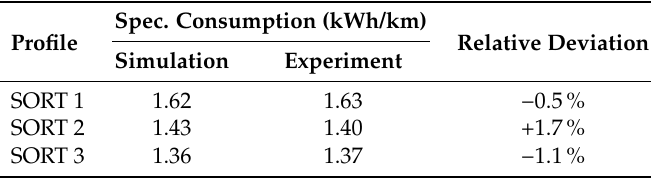
Table 4. Comparison of simulated and experimentally determined energy consumption for standard on-road test (SORT)